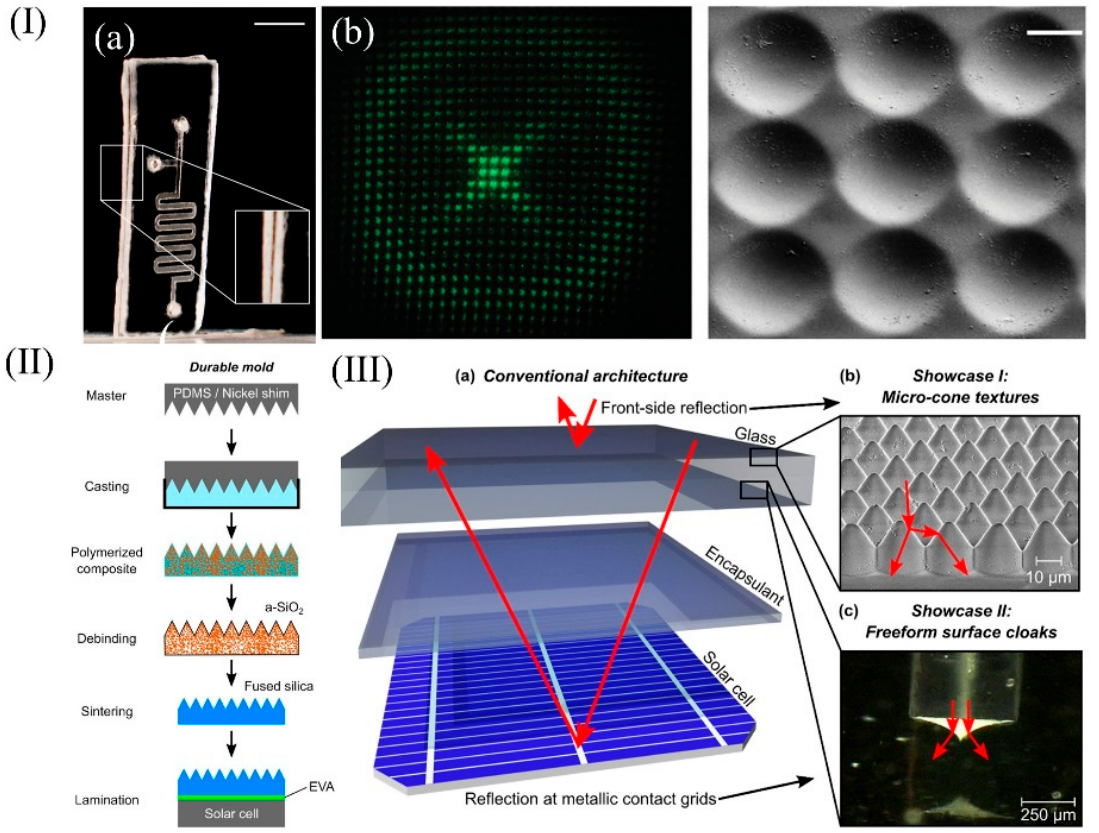
Figure 6. ( I ) ( a ) A microfluidic glass chip made using sheet lamination (scale bar: 4 mm). ( b ) Optical projection pattern obtained from a replicated micro-optical lens array made using sheet lamination with SEM image (scale bar: 15 µ m). ( II ) The processes of the sheet lamination. ( III ) ( a ) Schematic of the c-Si solar module architecture. ( b ) SEM image of the front-side reflection obtained by texturing the front cover glass and ( c ) reflection of metallic front contacts obtained by embedding free-form surface (FFS) cloaks into the front cover glass. ( I ) Reprinted with permission from ref. [33]. ( II , III ) Reprinted with permission from ref.